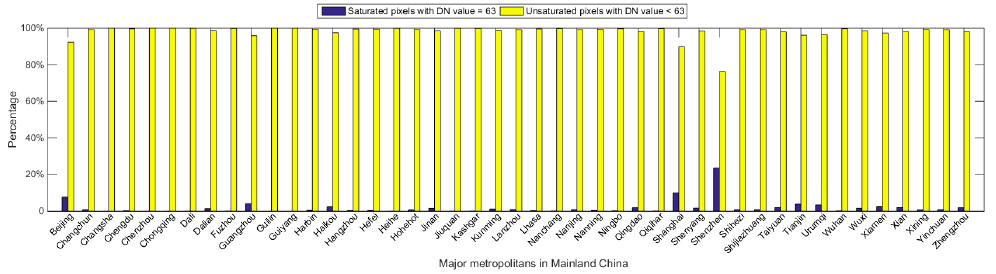
Figure 9. Average percentages of saturated and unsaturated pixels from 1992 to 2013 for individual